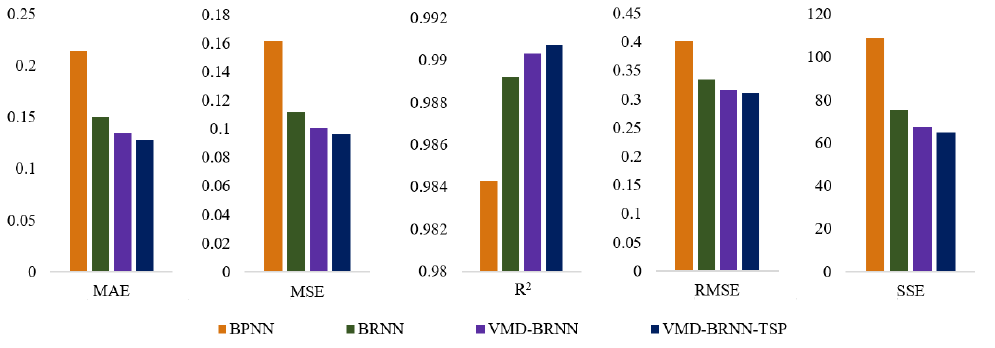
Figure 9. Error comparison chart.